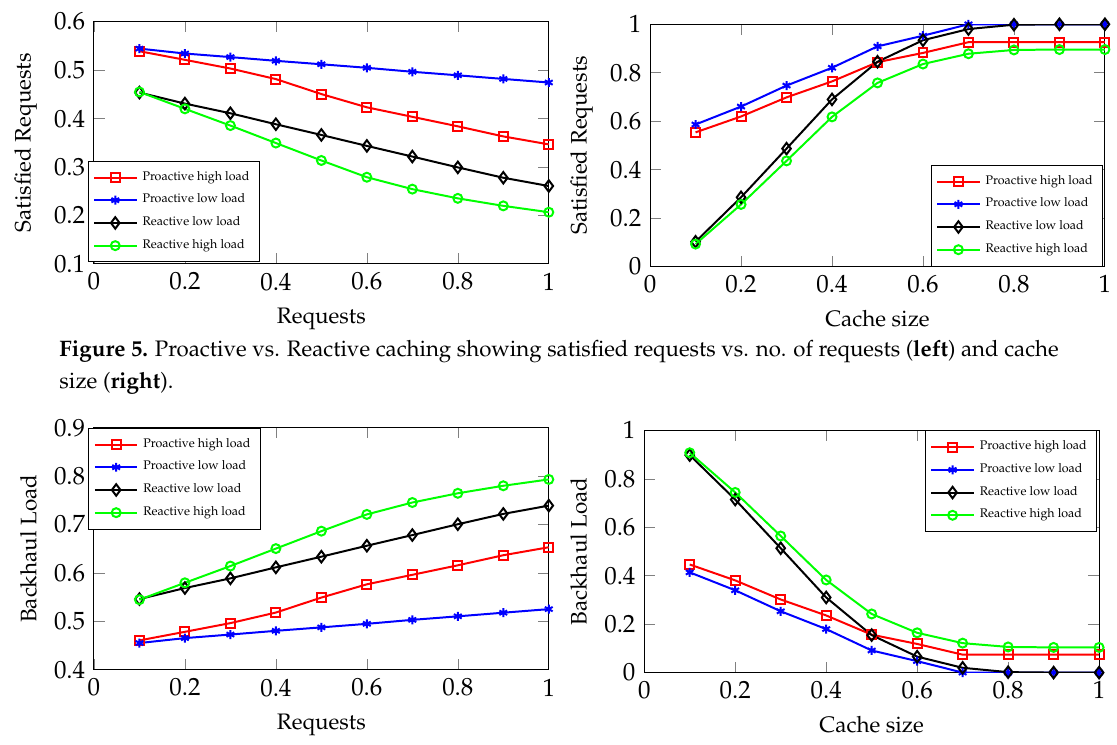
Figure 6. Proactive vs. Reactive caching showing backhaul load vs. no. of requests ( left ) and cache size ( right